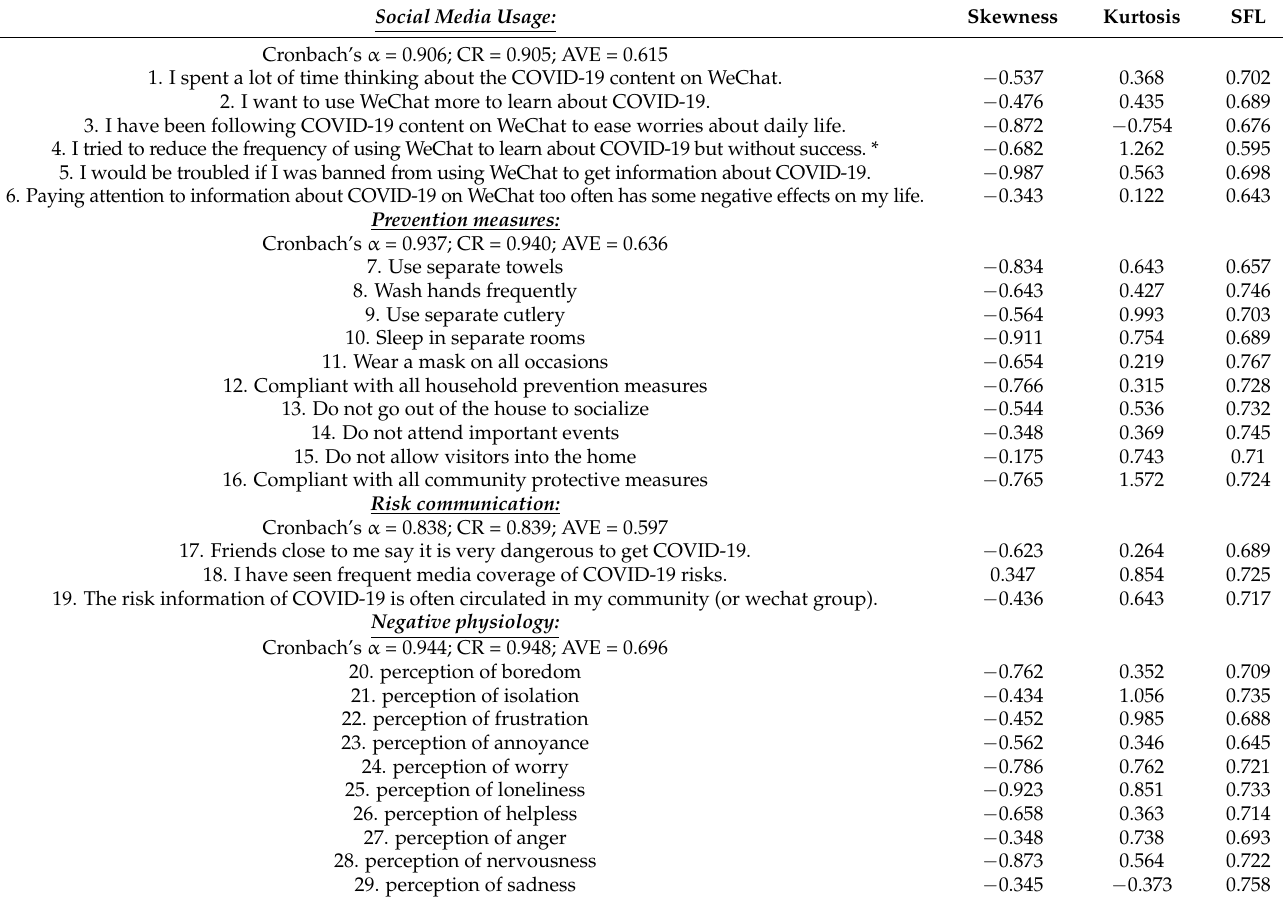
Table 2. Assessment of the items and variables (N =